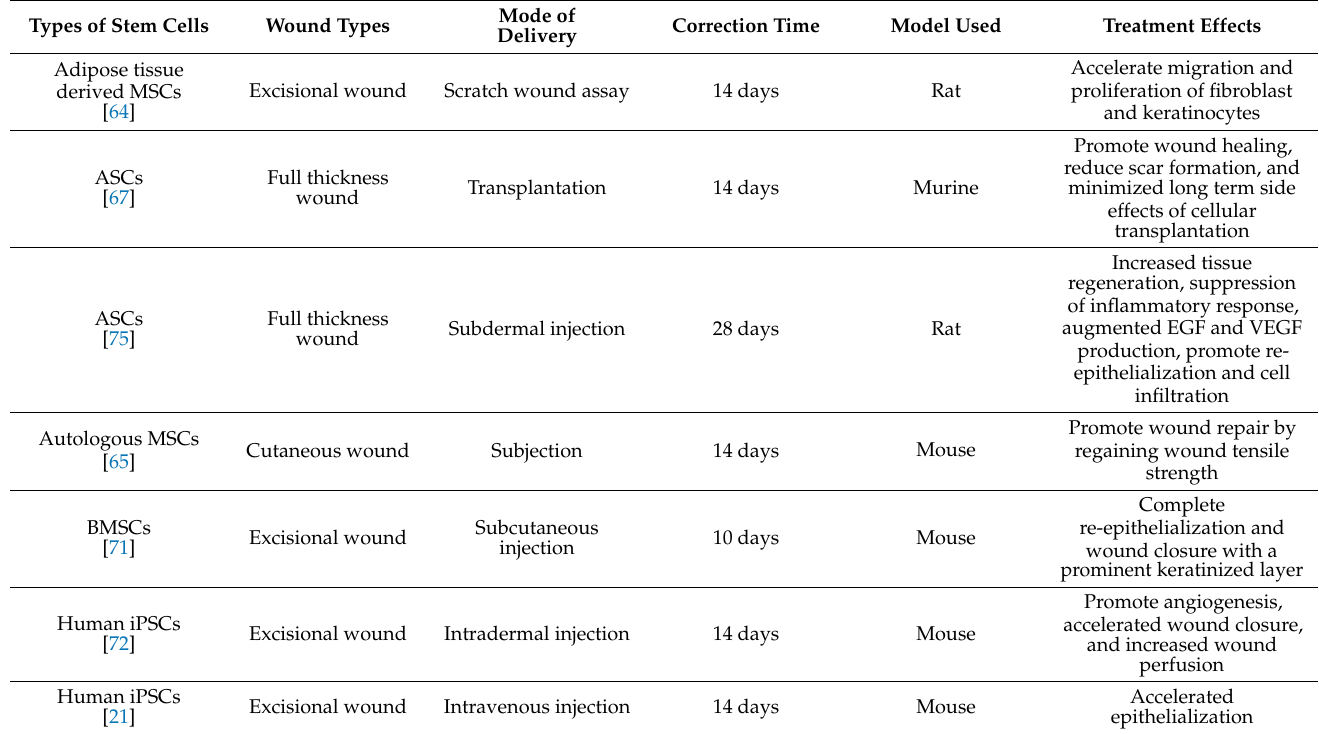
Table 3. Use of various stem cells in wound